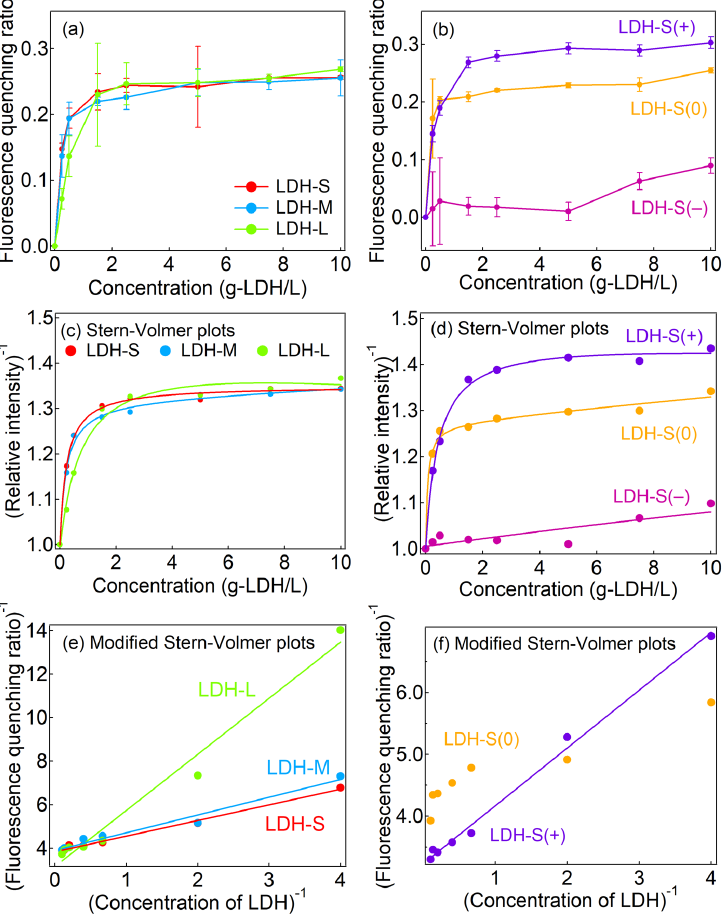
Figure 3. Fluorescence quenching ratios of blood plasma by LDHs from the aspects of ( a ) size and ( b ) surface charge dependence and Stern–Volmer and modified Stern–Volmer plots for fluorescence quenching for blood plasma by LDHs with different ( c , e ) particle sizes and ( d , f ) surface charges. Solid lines were obtained by fitting with Equation (7) for ( c , d ) and (6) for ( e , f ) in the Experimental Section. A modified Stern–Volmer plot for LDH-S( − ) are shown in Figure S11 in Supplementary Materials.